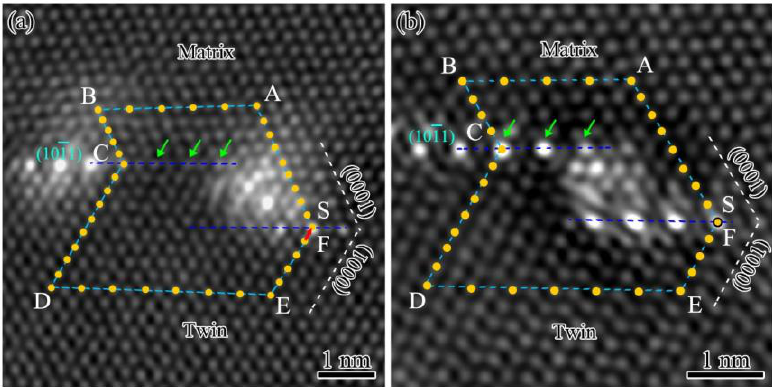
Figure 4. Atomic-scale HAADF-STEM images of micro-step II in [12 ̅ 10] zone axis marked with a Burgers circuit: ( a ) A micro-step with misfit dislocation; ( b ) a micro-step free of dislocation.